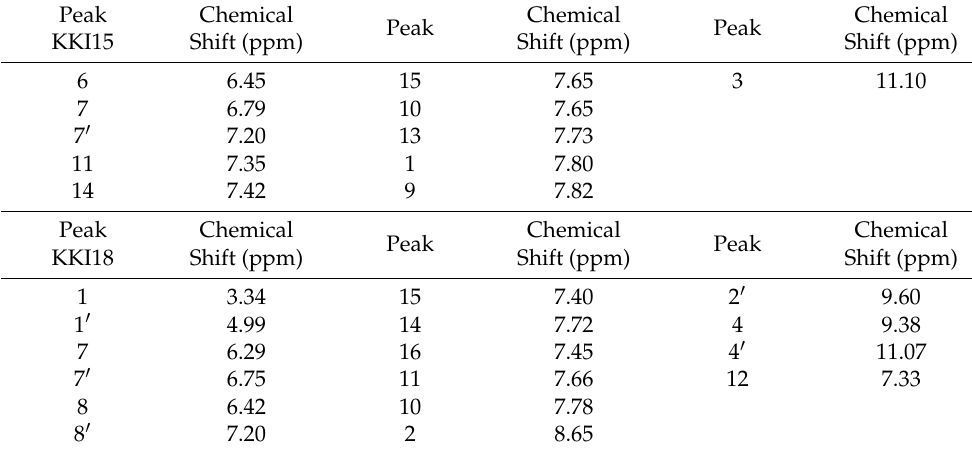
Figure 3. 1 H NMR spectra in DMSO of KKI15 ( top ) and KKI18 ( bottom ). The spectra were recorded in DMSO-d 6 on a Bruker AC 800MHz spectrometer at 25 ◦ C. Table 1. Assignment of the experimental 1 H NMR spectra of ΚΚΙ 15 and KKI18 in DMSO-d6.